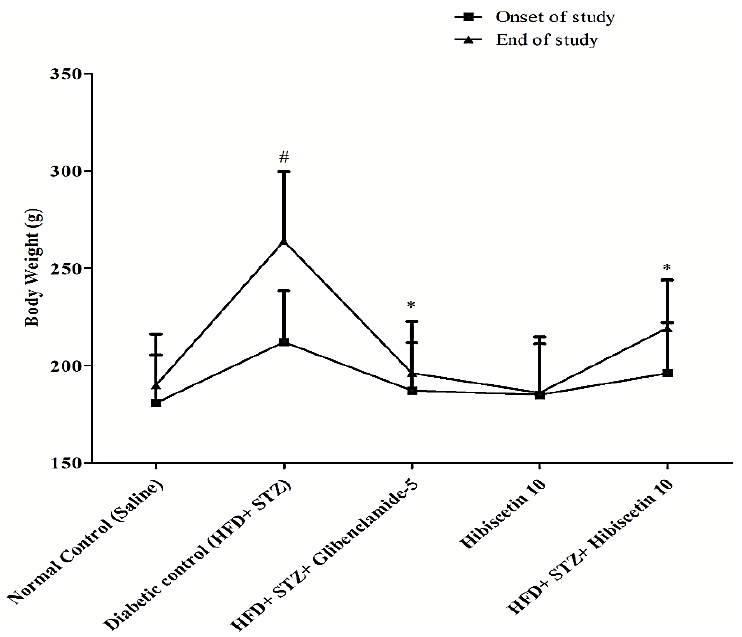
Figure 1. Hibiscetin affects body weight monitoring (n = 6). The mean SEM is used to express the data. The mean SEM is used to express the data; (# p < 0.05) saline vs. HFD+STZ; (* p <0.05) HFD+STZ vs. treatment group.